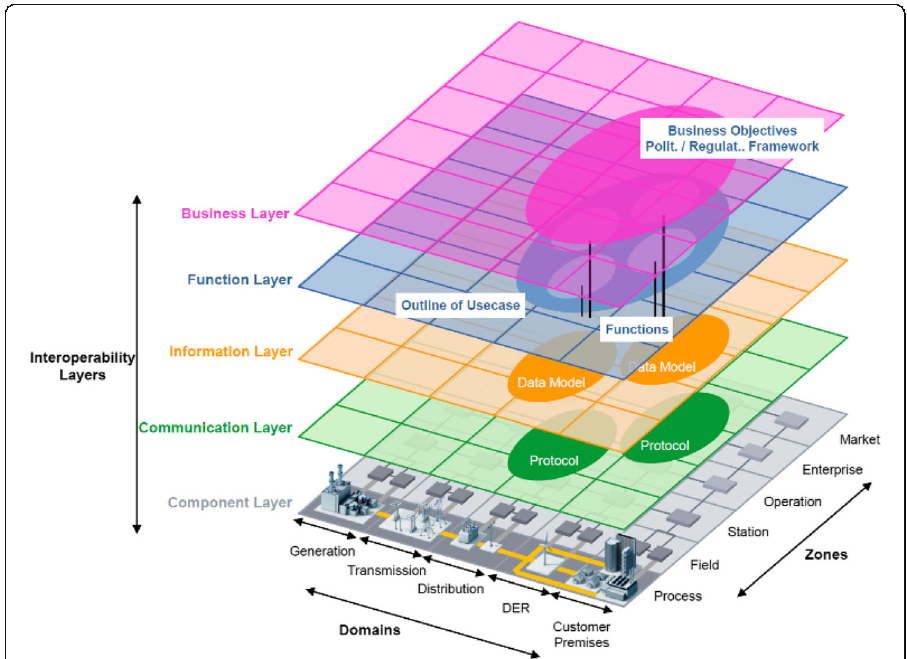
Fig. 8 SGAM framework (CEN-CENELEC-ETSI Smart Grid Coordination Group 2012)